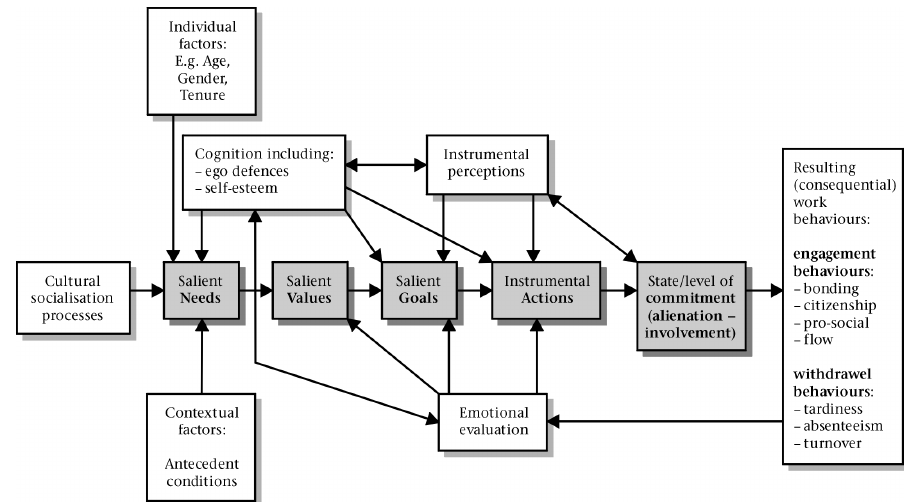
Figure 4: A baseline motivational model for illustrating work commitment –